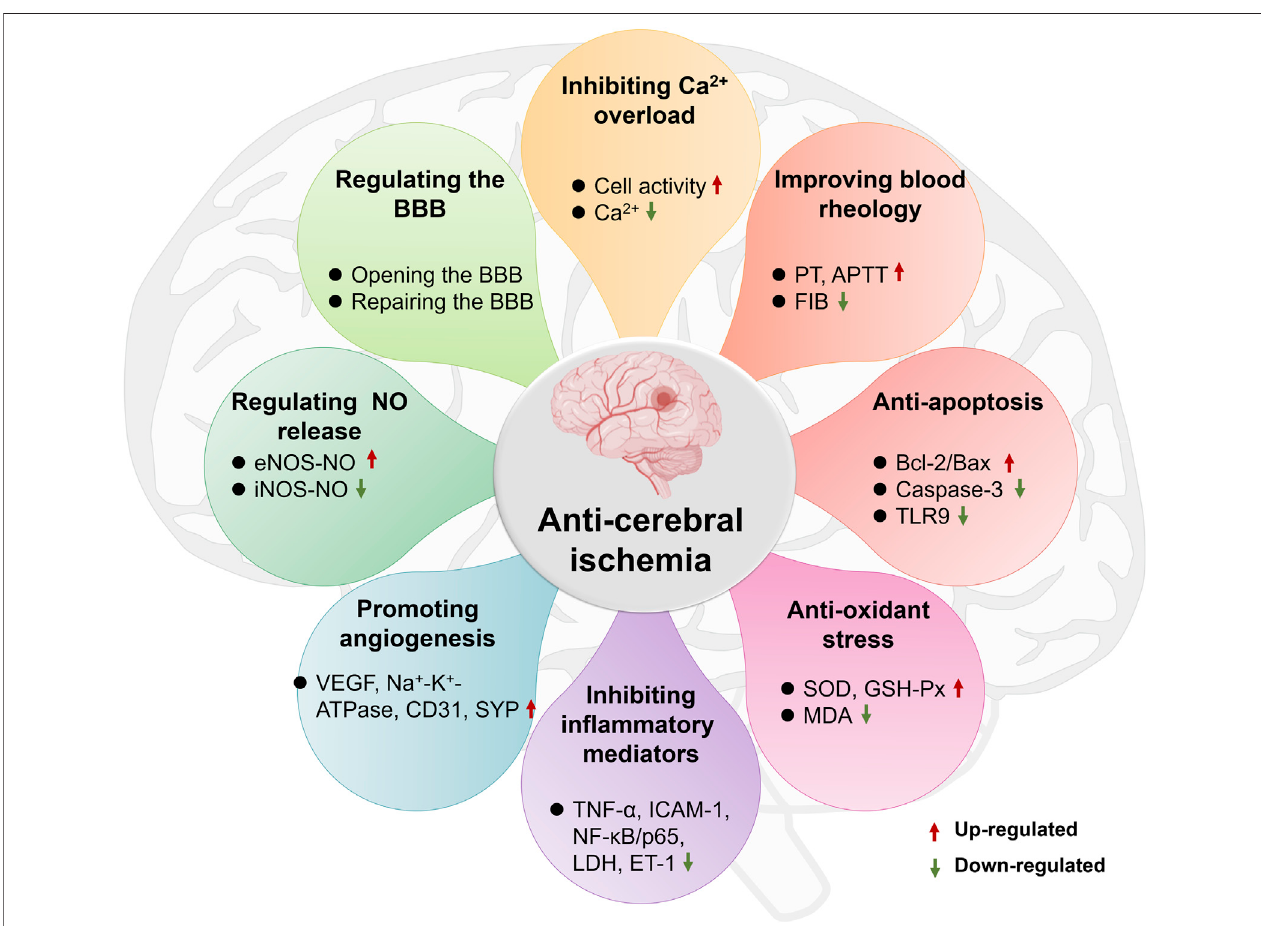
FIGURE 5 | The main pharmacological mechanism of storax on cerebral